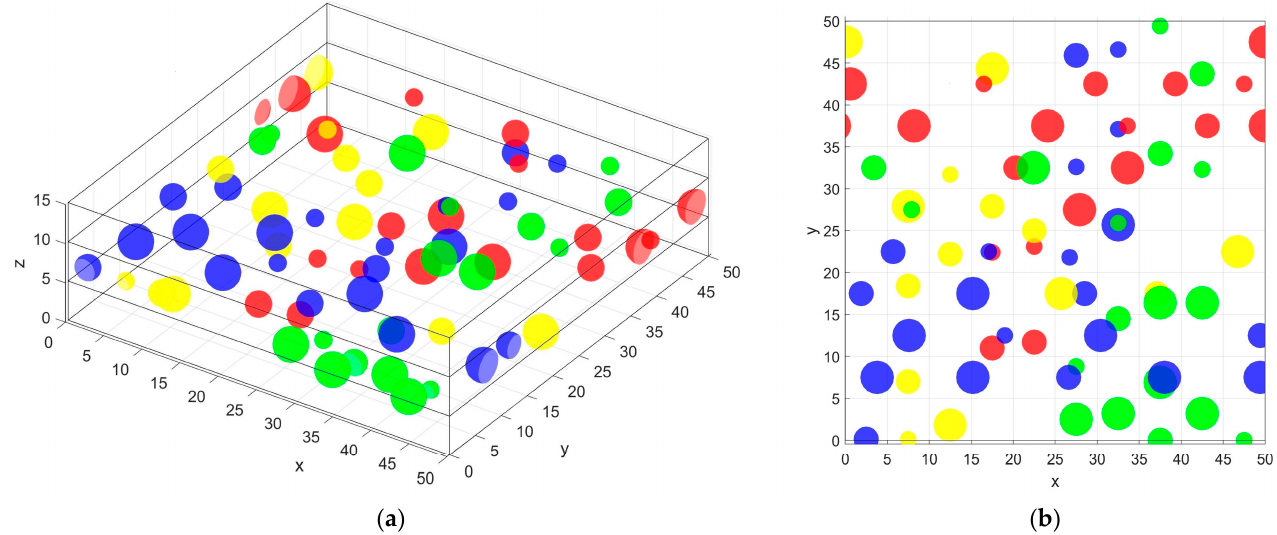
Figure 32. Snapshot of the intersection when there are 72 UAVs in the intersection in ( a ) 3D view and in ( b ) x-y view. One UAV is represented by one color and UAVs coming from the same way have the same color.